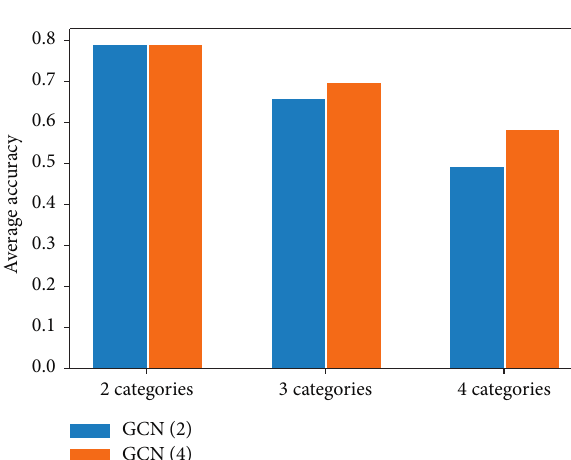
Figure 5: Average accuracy under different discriminative features and category